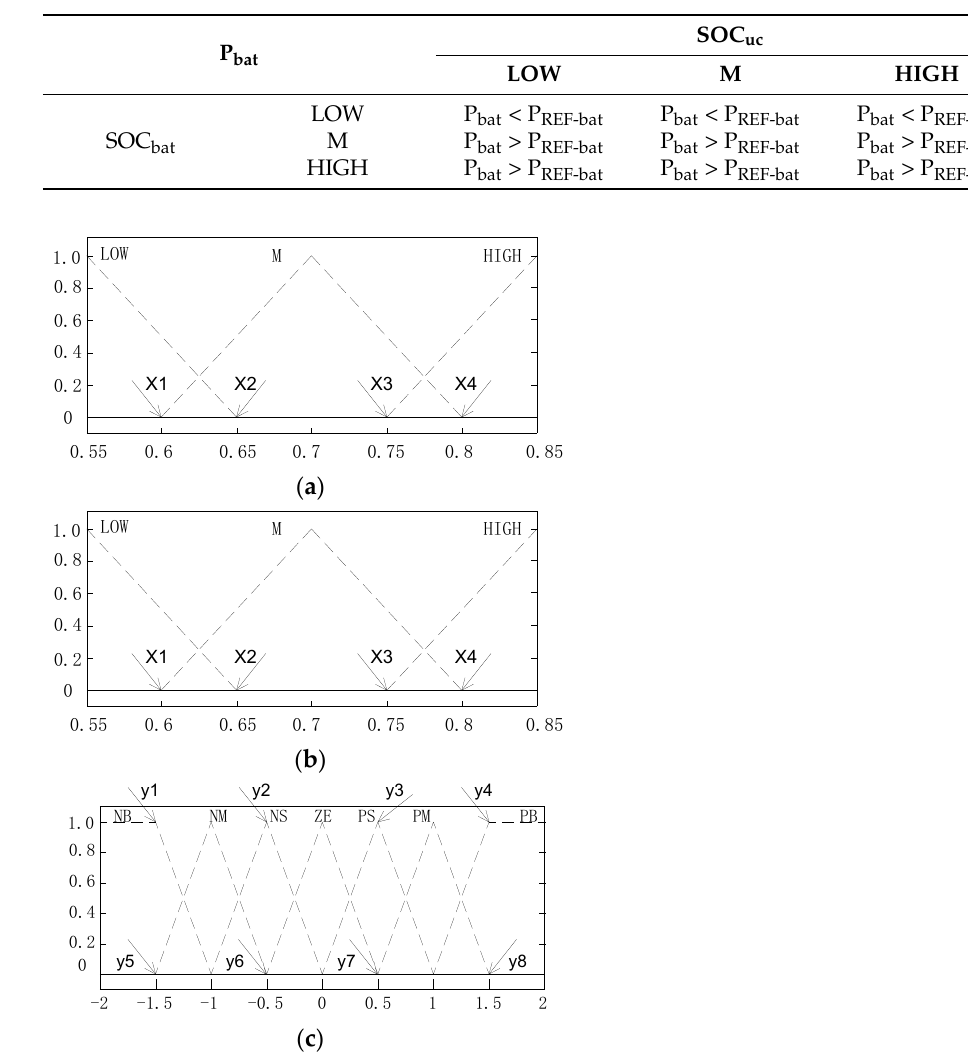
Table 4. Fuzzy rules under driving conditions.